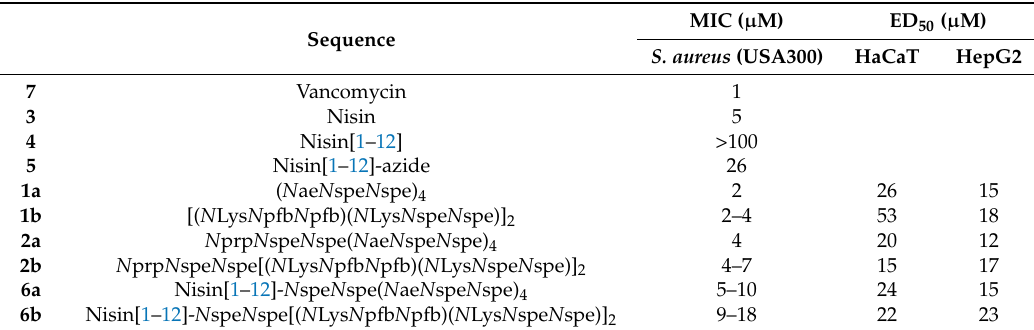
Table 1. Biological evaluation of peptide–peptoid conjugates and other fragments for comparison against methicillin-resistant S. aureus 300. Peptoids and peptide–peptoid hybrids show potent antibacterial